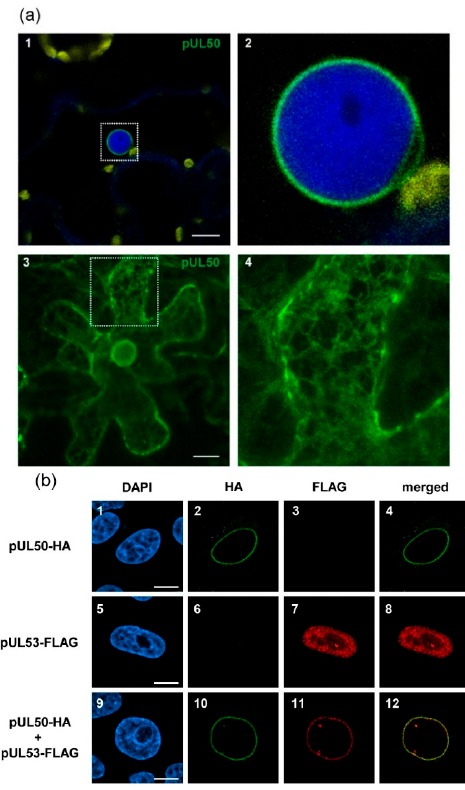
Figure 1. Expression and localization of pUL50 ( a ) Transient expression of eGFP::pUL50 in Nicotiana benthamiana : panel 1, DAPI-staining was performed to identify nuclei (blue), the GFP-fusion construct (green) was localized to the nuclear envelope; chloroplast autofluorescence is shown in yellow, the dotted box indicates the section shown in panel 2; panel 2, magnified section from panel 1; panel 3, pUL50 also localized to the endoplasmic reticulum in Nicotiana benthamiana , maximum projection of a z-stack image, the dotted box indicates the section shown in panel 4; panel 4, magnified section from panel 3 reveals the localization of eGFP::pUL50 to the net-like structure of the endoplasmic reticulum; ( b ) Immunolocalization of pUL50-HA (green) and pUL53-FLAG (red) in HeLa cells: Panels 1-4, single transfection of pUL50-HA in DAPI (blue) stained cells revealed the localization to the nuclear envelope; panels 5-8, single transfection of pUL53-FLAG in DAPI stained cells showed nucleoplasmic localization; panels 9-12, cotransfection of pUL50-HA and pUL53-FLAG demonstrating the potential of pUL50 to recruit pUL53 to the nuclear rim. White bars represent 10 µ